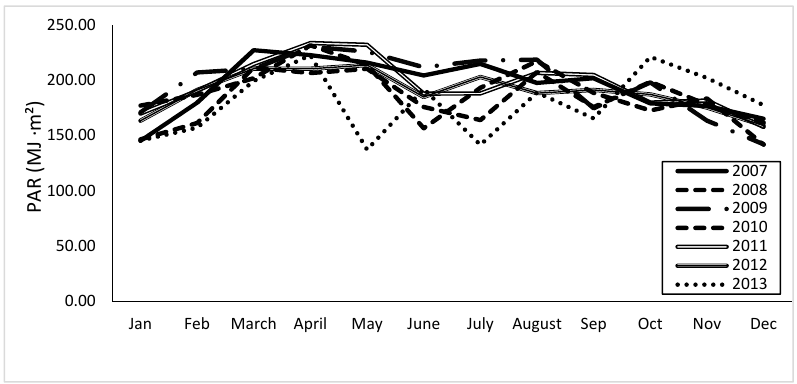
Figure 3. Temporal variation of average Photosynthetic Active Radiation (PAR) over the years in the study area.